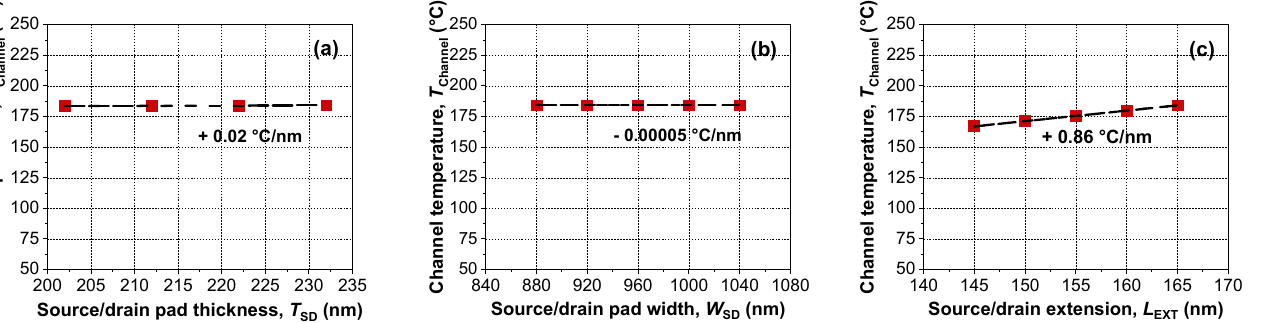
Figure 8. Extracted T Channel of devices with various ( a ) S/D pad thicknesses, ( b ) S/D pad widths, and ( b , c ) S/D extension lengths. Dashed lines indicate linear fits of the experimental data.